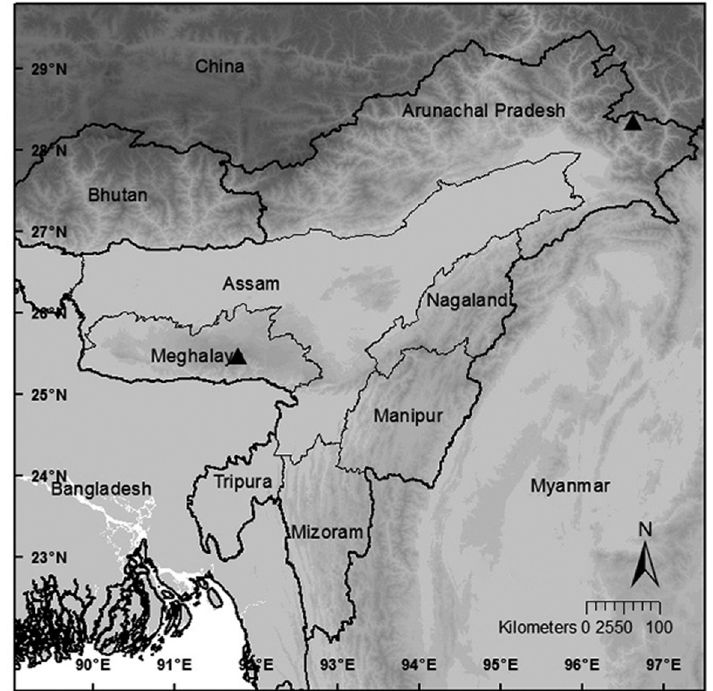
Fig. 36. Map showing the location of B. labordei H.Lév.